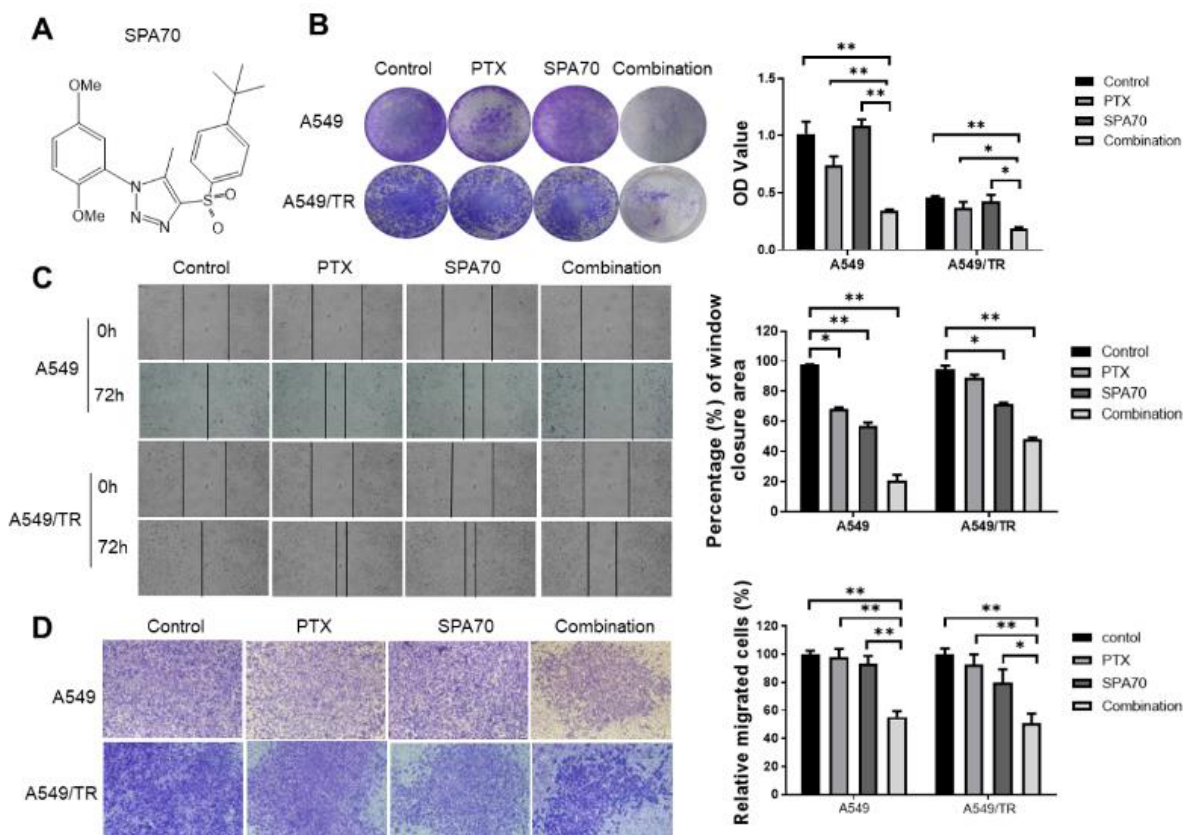
Figure 1. The effect of PTX, SPA70 and combination treatment on the cell colony formation and migration, invasion effects of PTX, SPA70 and combination on A549, A549/TR cells. ( A ) Chemical structure of SPA70. ( B ) Representative images from the colony formation assay, and the quantification of the results from A549, A549/TR. The experiment was conducted using 1 nM PTX, 5 µ M SPA70 in 12-well plates with triplicates. Colonies were lysed in buffer with SDS and read the absorbance at 490 nm. Quantification was applied to show relative cell viability. One-way ANOVA test was performed for statistical significance. *, p < 0.05; **, p < 0.01, compared with indicated groups. ( C ) Wound healing assay was carried out in 12-well plates with triplicates and the photo was taken after drugs were added for 72 h. The drug concentration was 2 nM PTX and/or 10 µ M SPA70. The migrated cells that crossed the scratch line were quantified and displayed as percentage of total wound closure area. One-way ANOVA test was performed for statistical significance. *, p < 0.05; **, p < 0.01, compared with indicated groups. The photographs were taken by microscopy (200 × ). ( D ) 2 nM PTX and/or 10 µ M SPA70 were treated for 48 h and pictures were taken from the opposite side of the Matrigel-coated surface, which indicates the invaded cells to the lower chamber. The photographs were taken by microscopy (200 × ). Quantification was applied to show cell invasion. One-way ANOVA test was performed for statistical significance. *, p < 0.05; **, p < 0.01, compared with indicated groups.